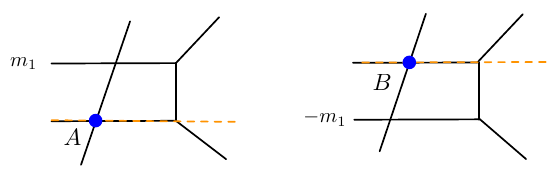
Figure 11 . There are two points A and B on its Higgs branch. Flipping (reflecting) the massive D5-brane relates these two vacua. Note that these two 3d brane webs cannot be related by HW transitions or flop